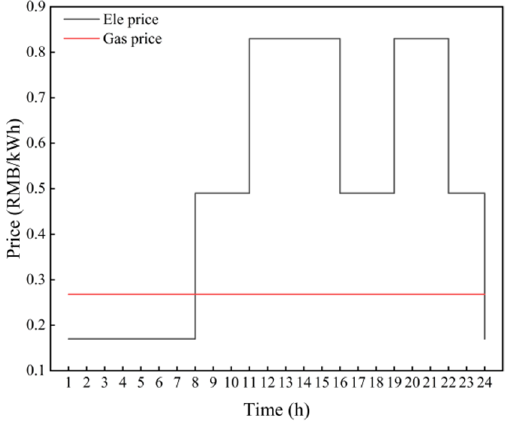
Figure 5. Energy price chart.